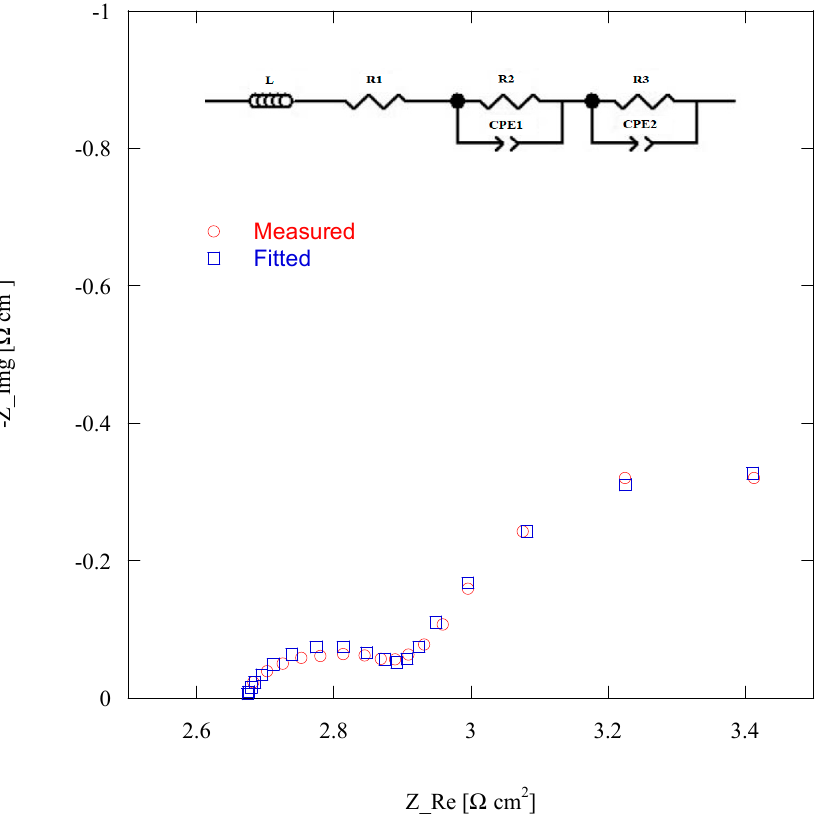
Figure 7. Nyquist plot at OCV of the LSCM/GDCE at 900 °C.